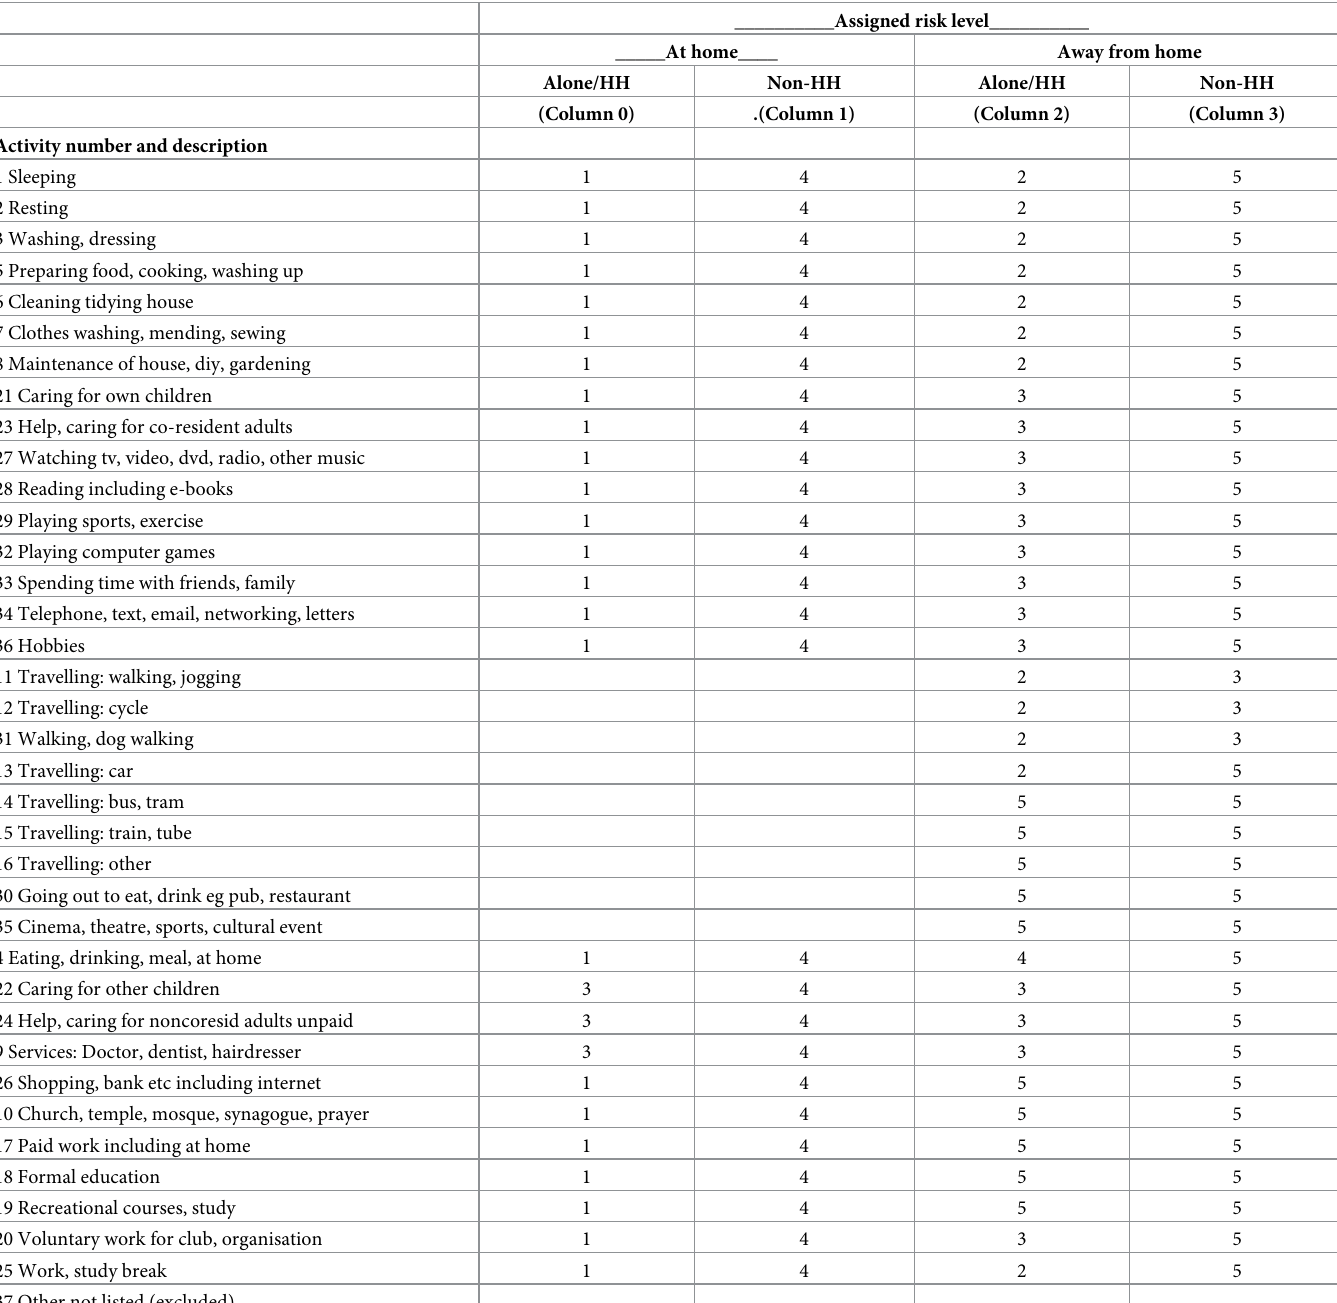
Table 2. Risk-level assignments, by activity, location and co-presence